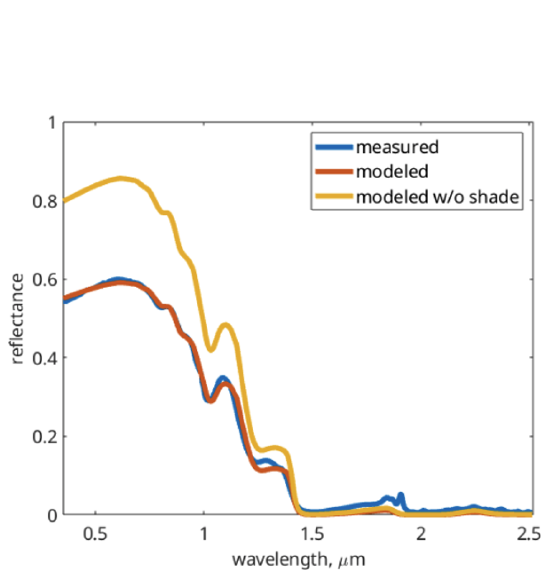
Figure 9. Example of measured and modeled reflectance from field spectroscopy measurements from 12 May 2021 (Table 2). The model estimates (with an RMSE = 0.006) are f shade = 0.31, grain radius = 454µm, dust concentration = 77 ppm, α apparent = 0.45 (measured/modeled), and α intrinsic = 0.66 (modeled without shade).